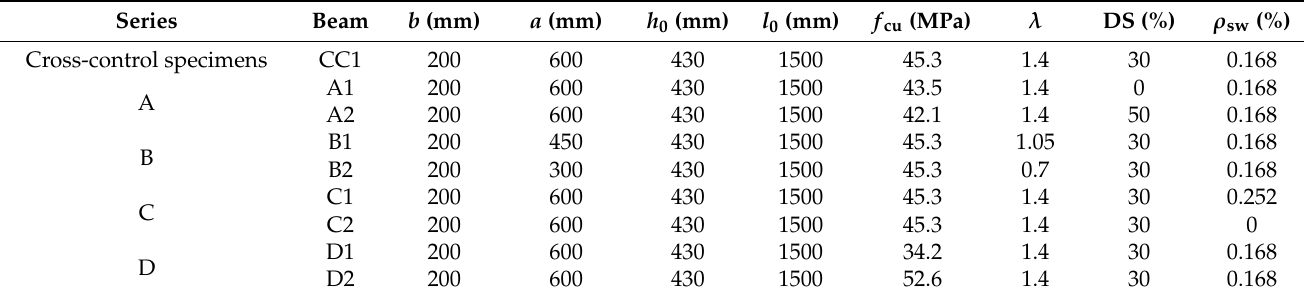
Figure 4. Cross-sectional view of the DSRC deep beam for stirrup rate ρ v = 0.252%. Table 5. Details of test beams. Table 5. Details of test beams.